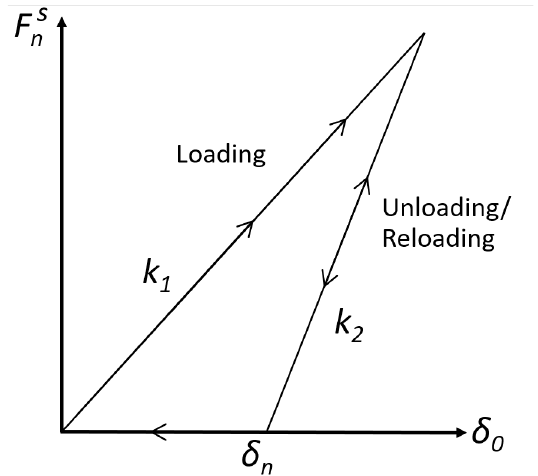
Figure 4. Hysteretic spring force-displacement relationship used in the hysteretic spring contact model (HSCM). Redrawn from Ucgul et al. [29].